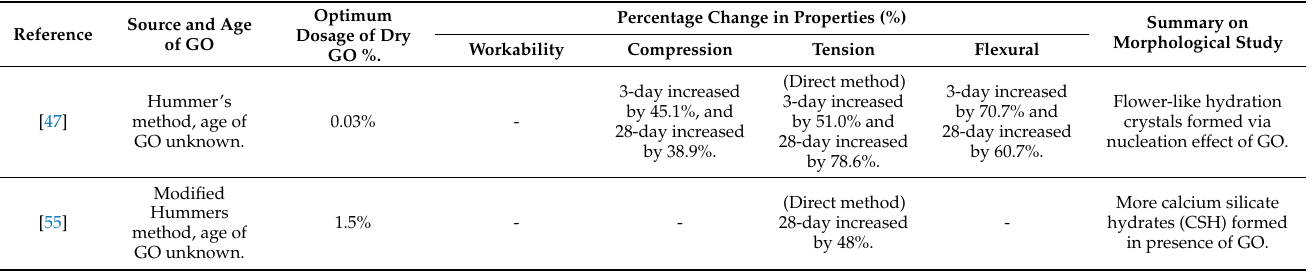
Table 1. Summary of key findings of past studies on GO incorporated cement mortar/cement